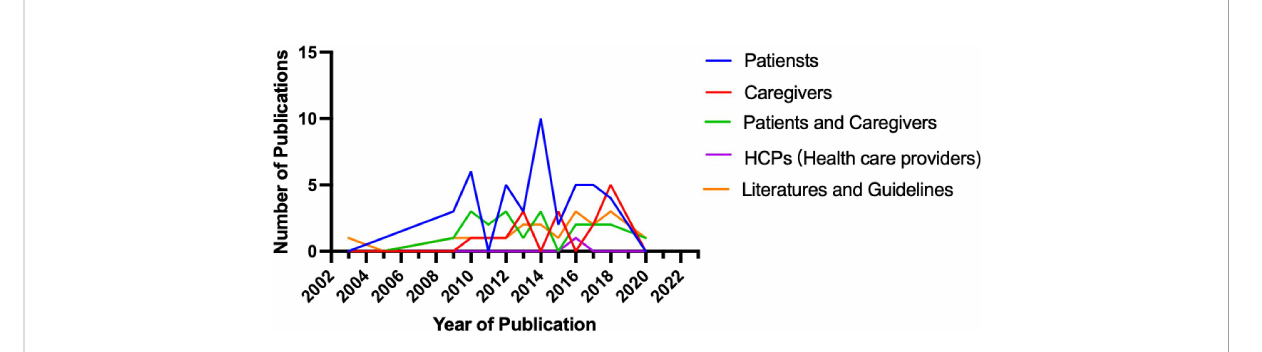
FIGURE 4 The top 100 cited article categories based on the research subjects.